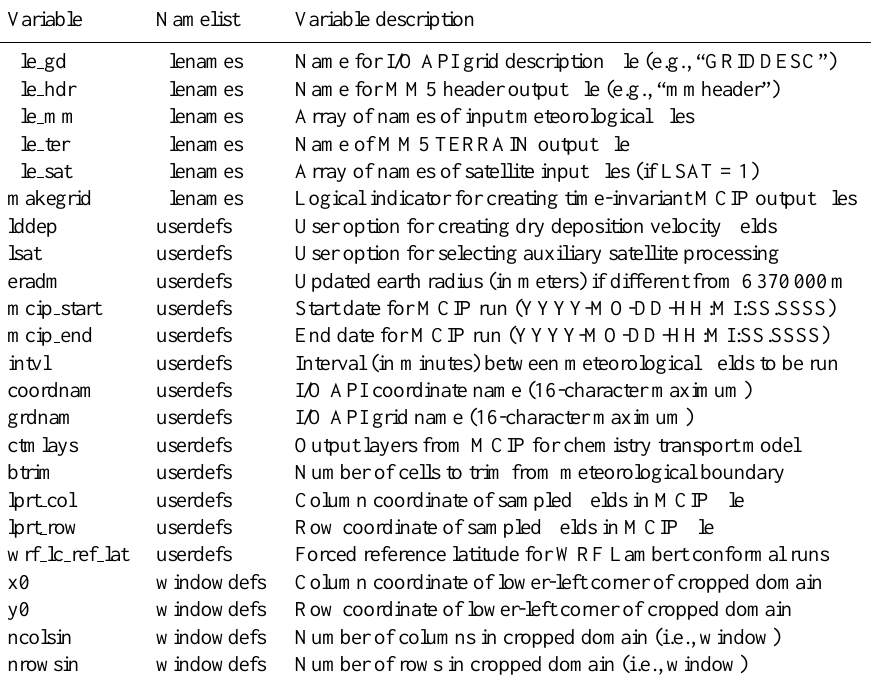
Table 1. User-definable run-time input for MCIP. Reasonable default values are provided in MCIP for all variables except the input file names (“file mm”), the start and end times (“mcip start” and “mcip end”), and the processing interval